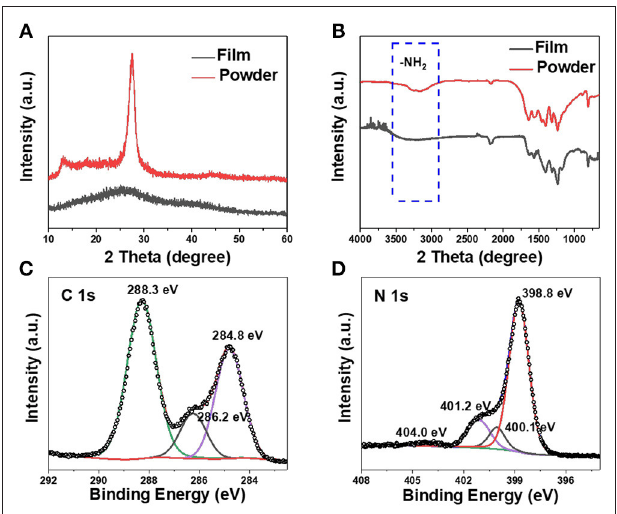
Figure 2B . The FTIR spectra of both film and powder samples show the typical breathing mode at about 810 cm − 1 , which is the characteristic absorption peak of the triazine unit in carbon nitride. The characteristic stretching modes of the C- N heterocycles was observed ranging from 1170 to 1630 cm − 1 . The peak at 2,180 cm − 1 correspond to an asymmetric stretching vibration of cyano groups (-C=N). The absorption peaks between 2900 and 3600 cm − 1 are -NH 2 groups. It is worth mentioning that no obvious differences can be found between the g-C 3 N 4 film and powder in the FTIR spectra, confirming the formation of g- C 3 N 4 structure. The above results matched well with previously reported values for g-C 3 N 4 with heptazine as a building bock.